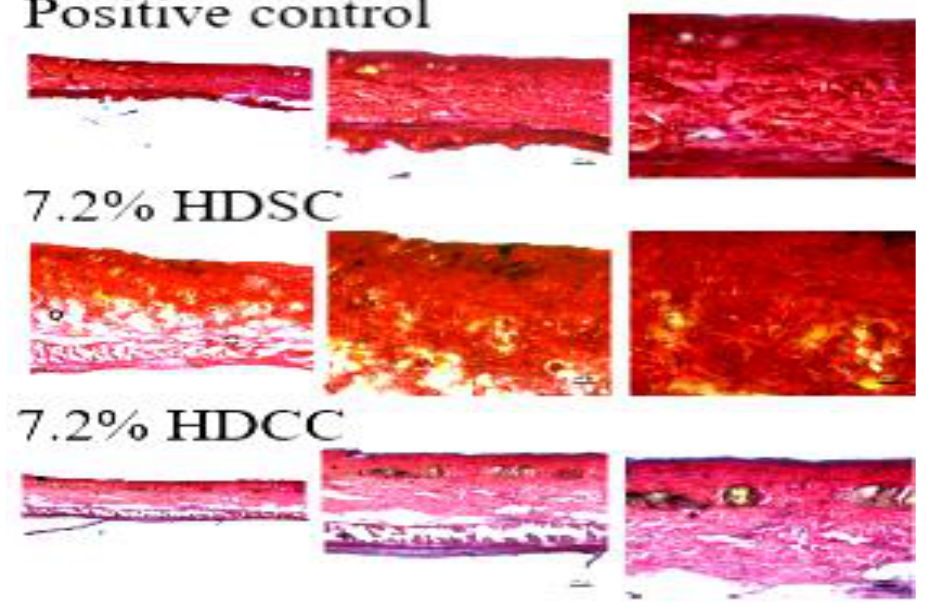
Figure 8. The histopathological images for the effect of positive control, 7.2% HDSC 7.2% and HDCC of wound healing using the Picrosirius – Hematoxylin.